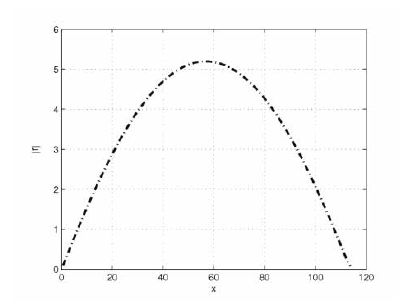
Figure 15. Distribution Re( (cid:5) p (cid:6) ), Im( (cid:5) p (cid:6) ) (new), L = 113 . 7, N = 536.